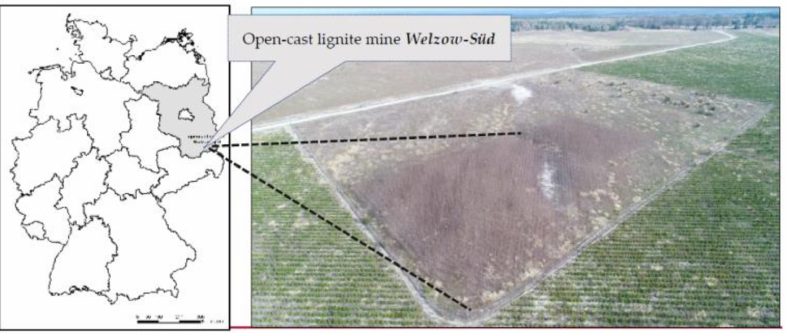
Figure 1. Map and aerial image showing our test plot in the north of lignite surface mine Welzow-Süd , photo taken on 12 April